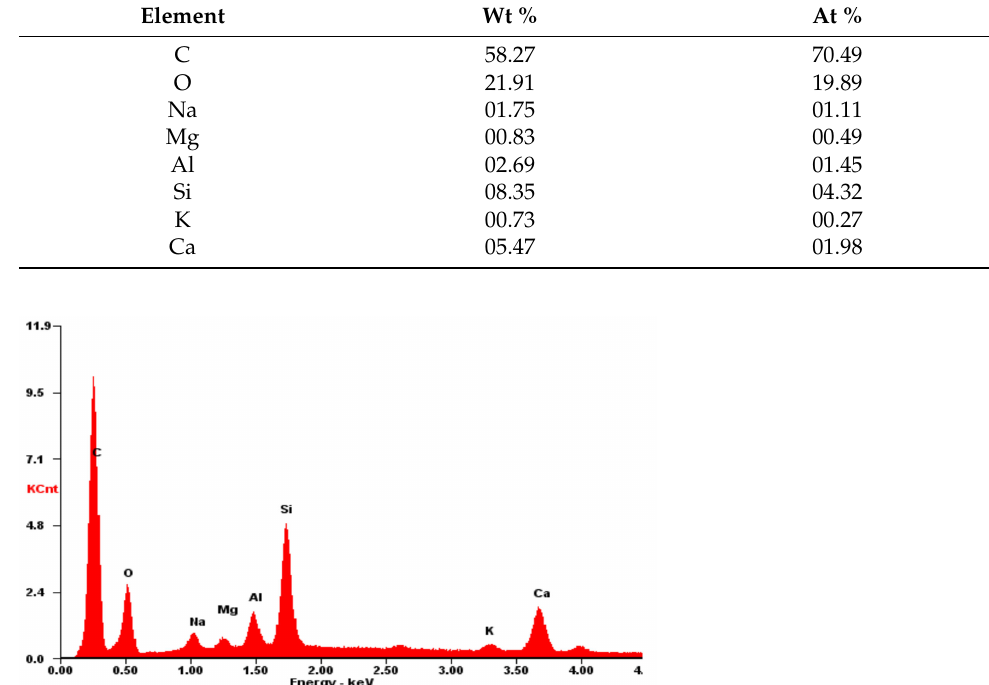
Table 2. Exemplary results of EDS tests on a textolite material with enhanced degradation effects. The weight (Wt) and atomic (At) composition of the laminate top layer in per cent are shown.